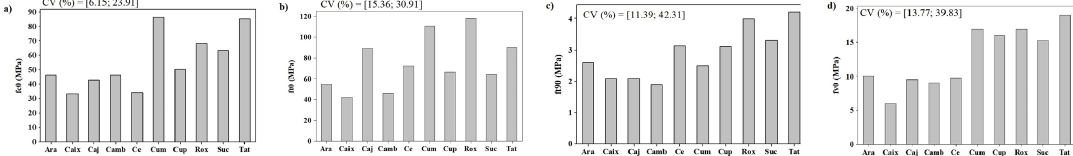
, f , f and f for wood species. (a) The variation of values of the strength in compression parallel to the Figure 2. Mean values of f c0 t0 t90 v0 fiber (f ), (b) tensile strength in parallel to the fiber to the (f ) and (c) perpendicular (f ) directions and, (d) shear strength in the direction c0 t0 t90 parallel to the fibers (f ) as a function for wood species (Ara – Cedroarana; Cax – Caixeta; Caj – Cajueiro; Camb – Cambará; Ce –Cedro; v0 Cum – Cumaru; Cup – Cupiúba; Rox – Roxinho; Suc – Sucupira; Tat – Tatajuba), respectively. Inserted in these Figure 2a-d upper side the lower and higher values of the coefficient of variation (CV) obtained.